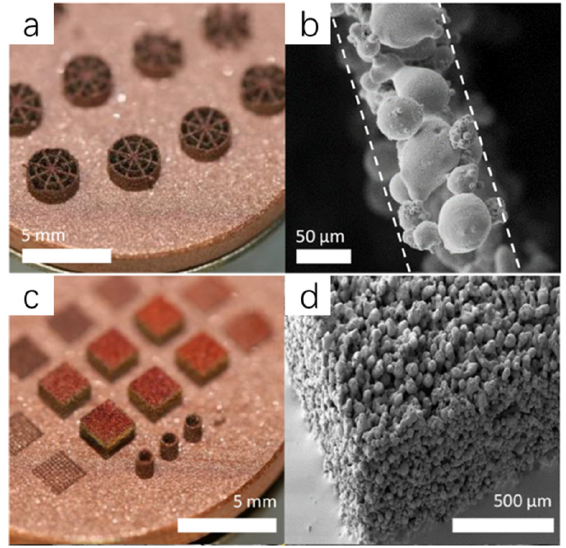
Figure 7. 3D image and SEM image of complex structures and block structure ( a ) 3D image of complex structures, ( b ) SEM image of complex structures, ( c ) 3D image of block structure, ( d ) SEM image of block structure. Reproduced with permission from [102], SpringerNature, 2017.